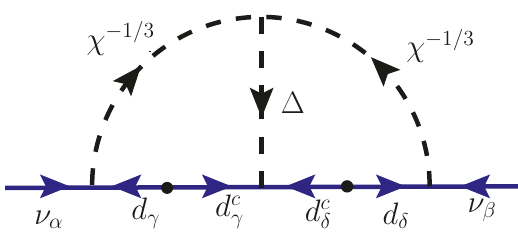
Figure 44 . Neutrino mass generation at two-loop in the LQ/DQ variant of the Zee-Babu model which generates operator [32], cf. eq. (1.4). O 11